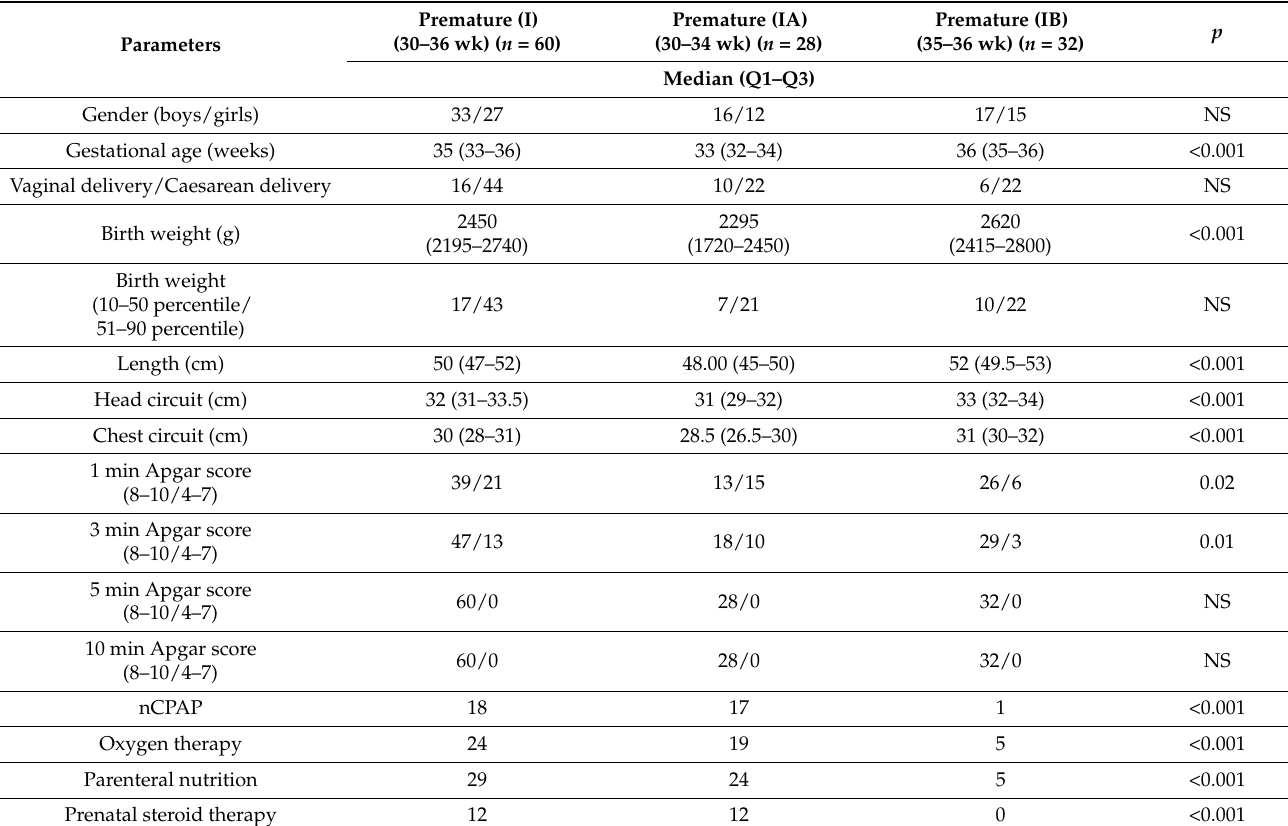
Table 1. Characteristics of premature